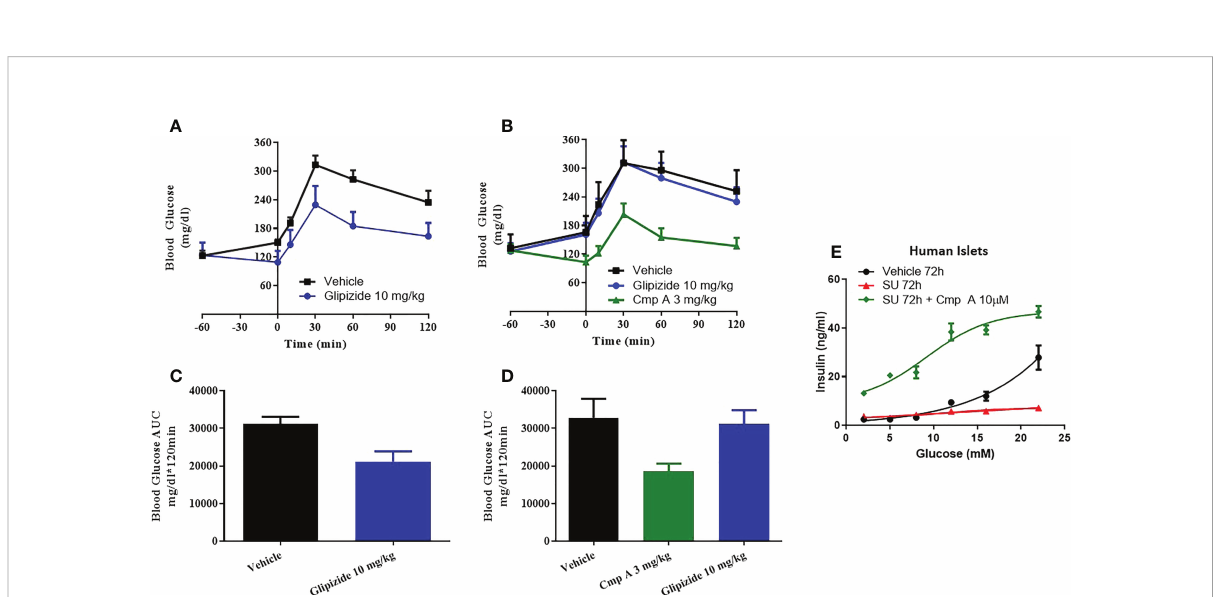
FIGURE 5 Sulfonylurea-induced secondary beta-cell failure. ZDF rats were chronically treated with vehicle (A) or the sulfonylurea (SU) Glipizide (B) for 25 days. On day 26 an OGTT was performed following acute treatment with Glipizide or compound (A) Quanti fi cation of the AUC for the OGTT after 25 day vehicle (C) or Glibenclamnide (D) treatment was measured. Ex vivo human islets were treated with another sulfonylurea, Glibenclamide, for 72h then challenged with acute glibenclamide treatment or Compound A (E) .